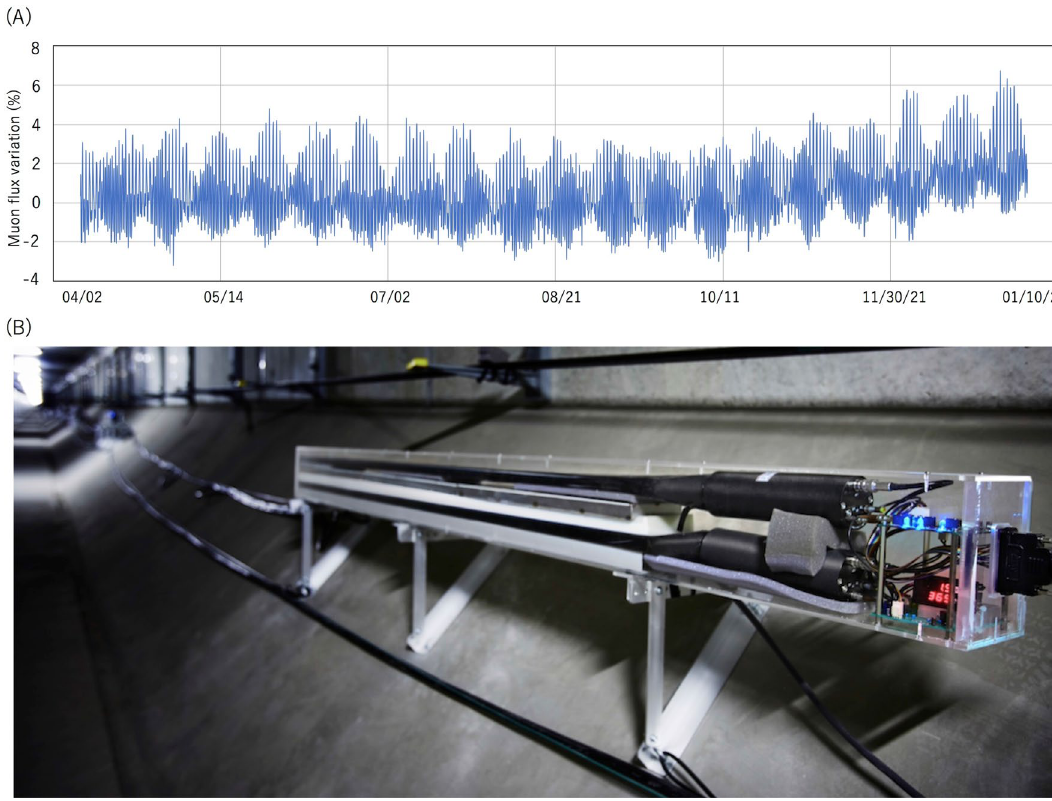
Figure 5. Tide variations recorded at TS-HKMSDD without any intermittency or measurement drift ( A ). A photograph of TS-HKMSDD MSM designed for collecting vertical muons is also shown ( B ). HKMT holds the copyright of the